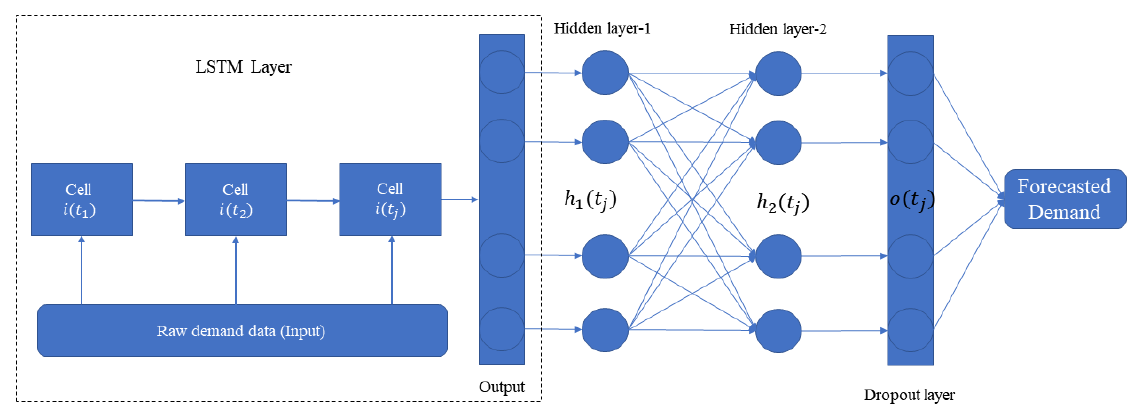
Figure 3. LSTM architecture on demand